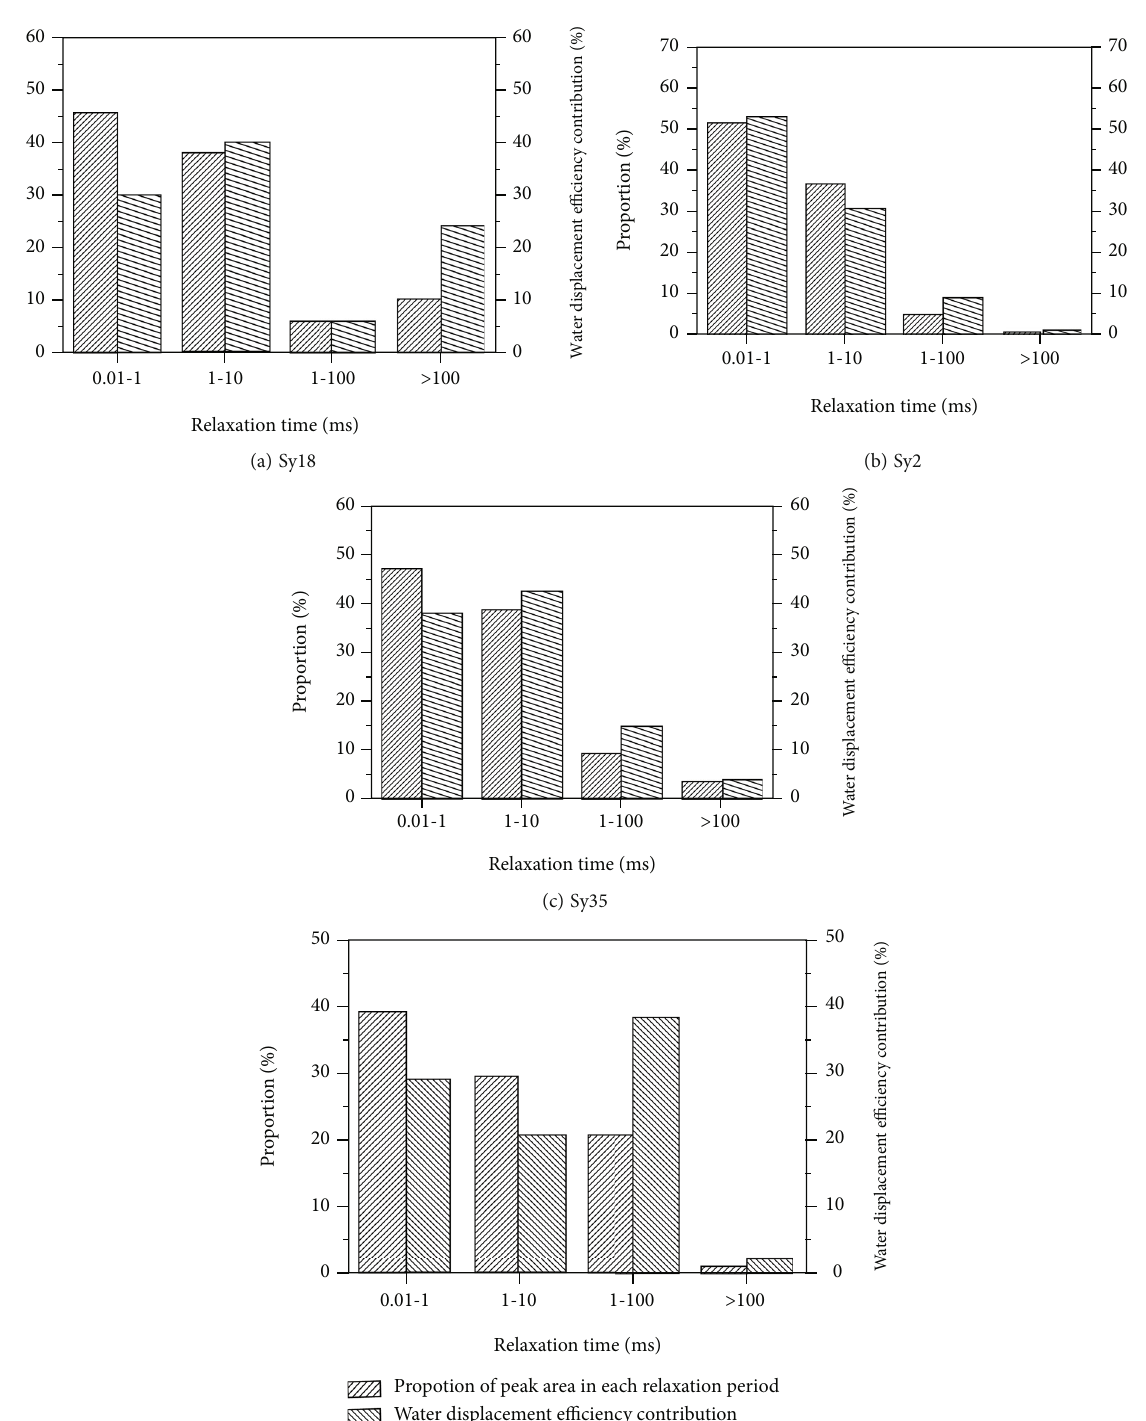
Figure 15: Proportions of the NMR peak area and the water displacement e ffi ciency contribution for di ff erent relaxation